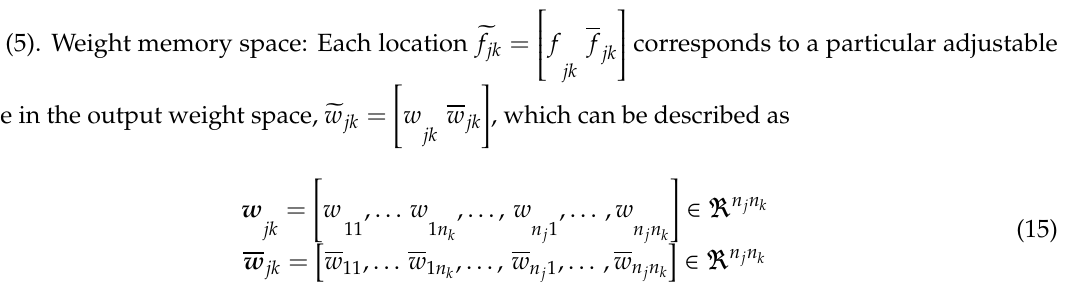
Figure 4. Mechanism for mapping two-dimensional inputs in the association memory space.